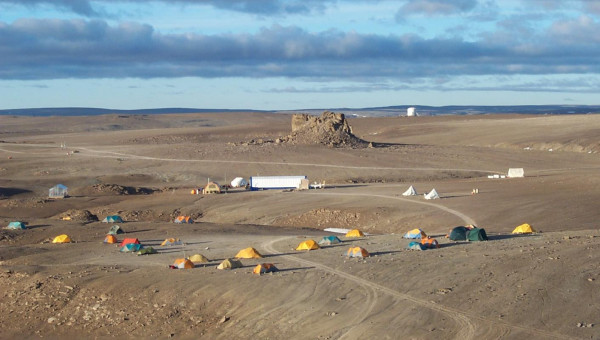
Overview photo showing the HMP Research Station and surrounding area at the time the study was conducted (Summer, 2002). The tent area in the foreground served as personal living quarters for HMP field participants. Immediately behind is the central base camp, consisting of core facilities, laboratory space, communications and mess tent, etc. The prototype Mars greenhouse is located to the left of the core facility. The rim of the impact crater is distant-right. The FMARS habitat, located on the crater rim, was not used in this study.